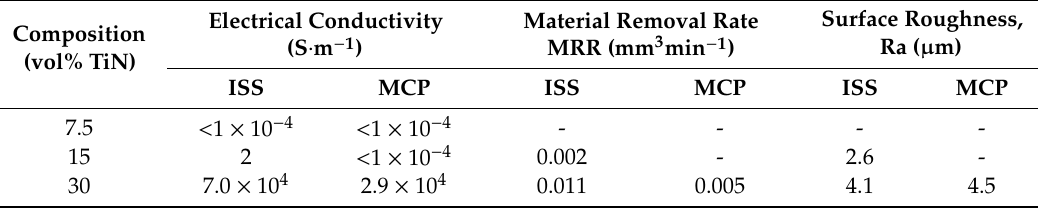
Table 2. Electrical conductivity, material removal rates and surface roughness of composites machined by die sinking electrical discharge